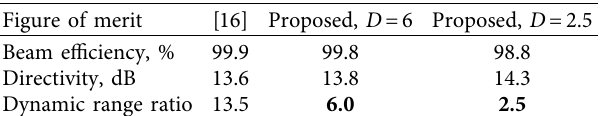
Table 7: Properties of proposed pencil beam arrays with 30 ele- ments and beamwidth of 12 ° , compared with array having maxi- mum efciency and unconstrained DRR [16]. Improvements are highlighted in bold.